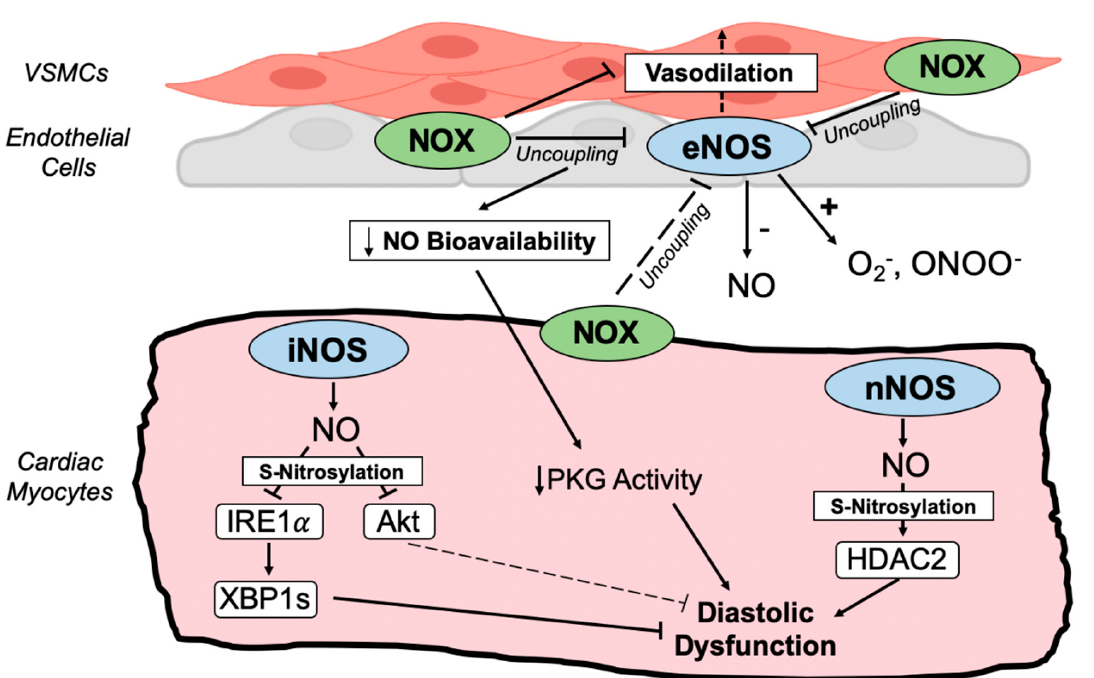
Figure 3. Crosstalk between NADPH oxidases and nitric oxide synthases. Schematic depiction of redox-nitroso crosstalk between coronary vasculature and cardiac myocytes in HFpEF. Endothelial NOS (eNOS) promotes vasodilation that is impaired when oxidative stress uncouples eNOS, diminishing NO bioavailability, cGMP levels, and protein kinase G (PKG) activity. Decreased myocardial PKG activity facilitates diastolic dysfunction by reducing titin phosphorylation. Uncoupled NOS enzymes generate damaging superoxide and peroxynitrite that further promote oxidative stress. Nitrosative stress in the HFpEF myocardium, on the other hand, is provoked by the upregulation of inducible NOS (iNOS) and neuronal NOS (nNOS) in cardiac myocytes. nNOS-dependent S-nitrosylation of histone deacetylase 2 (HDAC2) and defective XBP1 splicing (XBP1s) due to iNOS-dependent S-nitrosylation of IRE1 𝛼 promote diastolic dysfunction and heart failure in HFpEF animal models. iNOS also mediates Akt S-nitrosylation. NOS uncoupling and nitrosative stress-responsive signaling contribute to oxidative stress, coronary microvascular endothelial dysfunction, and impaired myocardial relaxation in HFpEF.